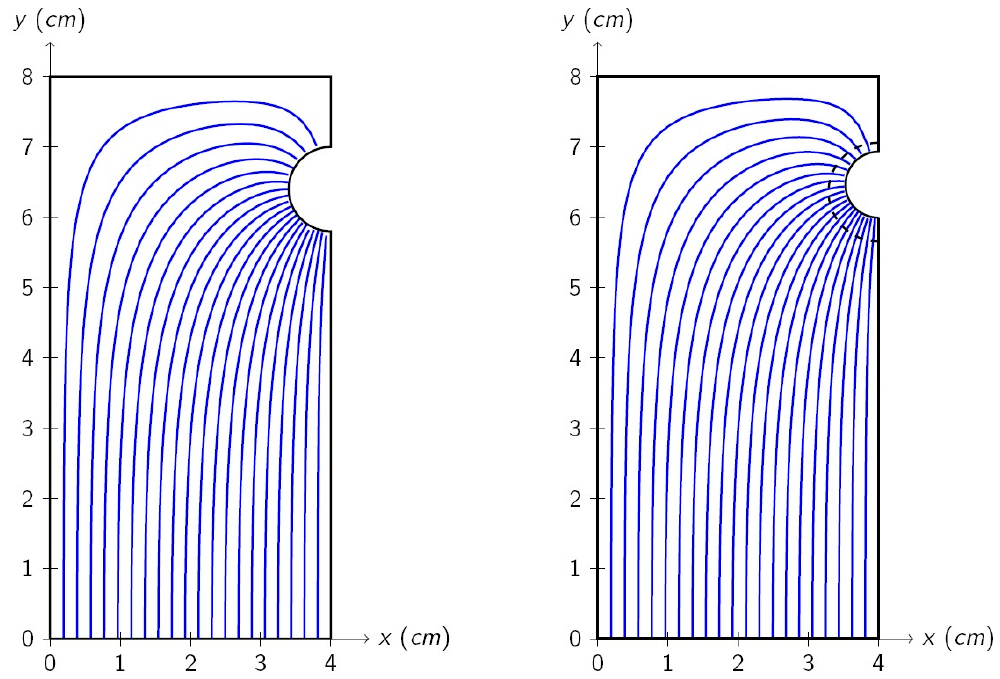
Figure 3. Current streamlines (20 of them are shown) initially (left) and after one year of corrosion (right). Dashed line shows the oxide layer. Appl. Sci. 2019 , 9 , x FOR PEER REVIEW